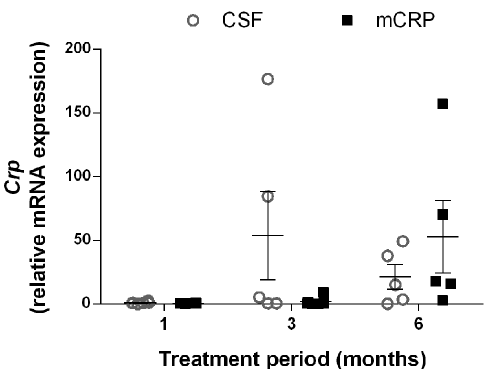
Figure 6. Exposure to mCRP did not induce a significantly increased expression of endogenous Crp gene at different times after its injection into the mouse hippocampus. Expression of Crp was normalized to the corresponding expression of Tbp gene and calculated as fold change of the 1-month CSF group. Values are mean ± SEM (1 month, CSF N = 6, mCRP N = 6; 3 months, CSF N = 5, mCRP N = 6; 6 months, CSF N = 5, mCRP N = 5).